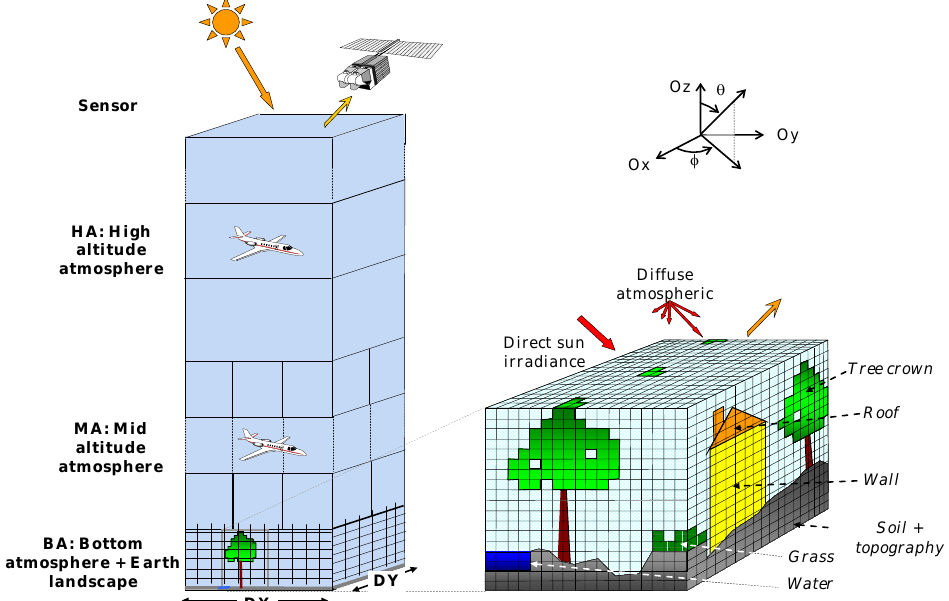
Figure 1. Radiative transfer modeling in the “Earth-Atmosphere” scene of the Discrete Anisotropic Radiative Transfer (DART) model. The scene of DART is divided into two parts: Earth and Atmosphere. Earth is represented with regular voxels while Atmosphere is represented with different horizontal layers.